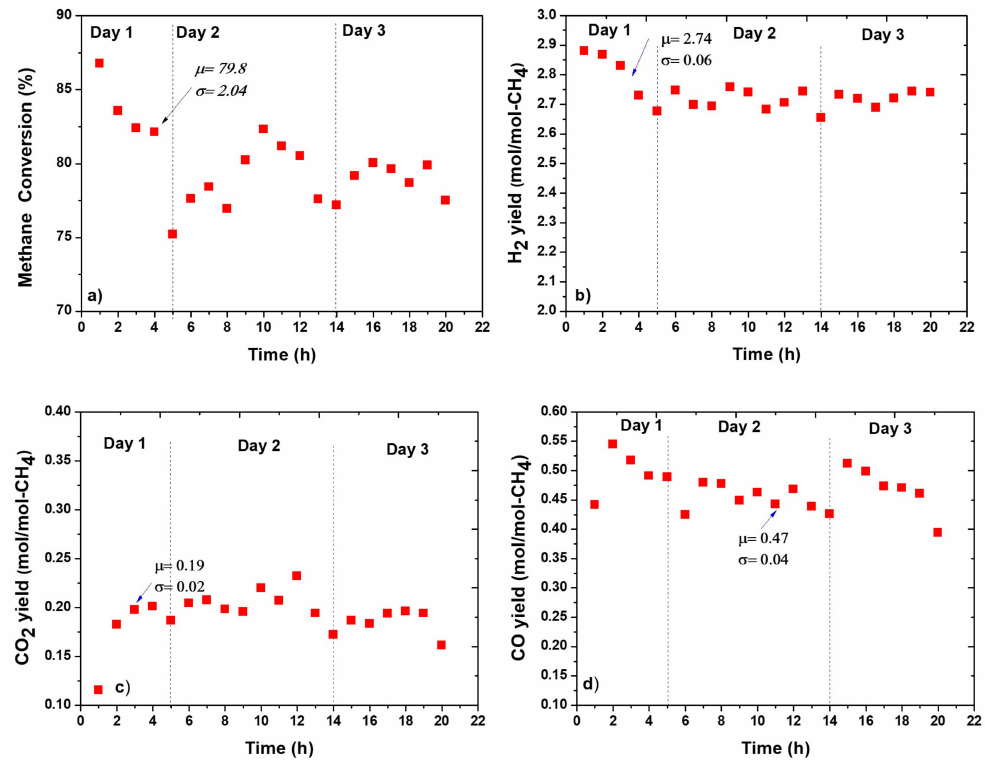
Figure 5. On-Off catalytic stability test of methane steam reforming at 700 ◦ C and S/C of 2 for 10%Ni/Al 2 O 3 catalyst, the values in the graph represent the average ( µ ) and variation ( σ ) for 20 h run: ( a ) Methane conversion ( b ) H 2 yield, ( c ) CO 2 yield, and ( d ) CO